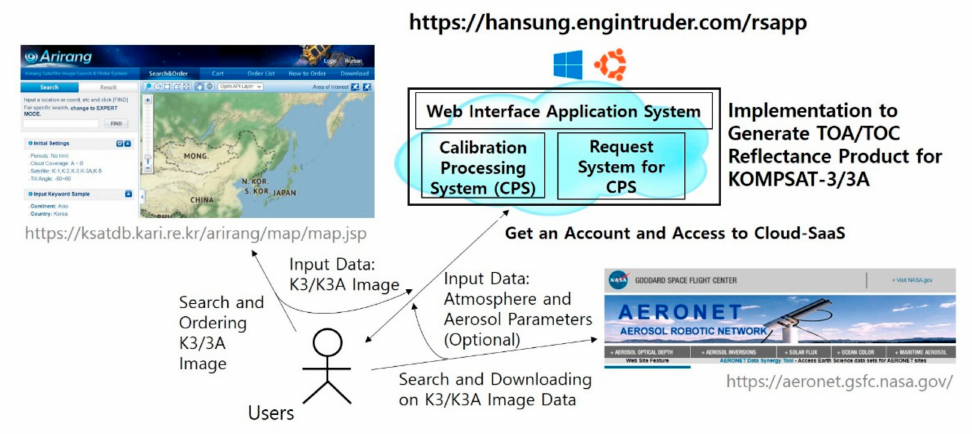
Figure 1. SaaS application view from the user side for KOMPSAT-3 (K3) and KOMPSAT-3A (K3A) bundle image